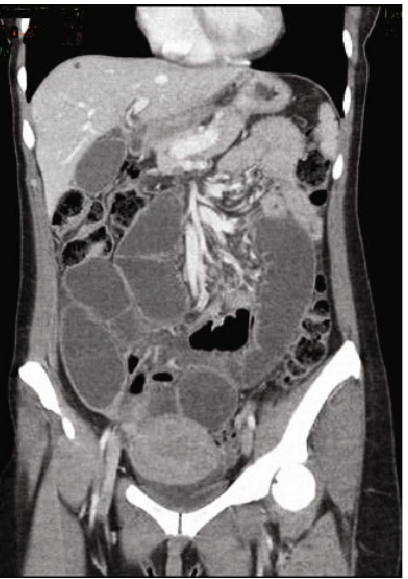
Figure 1: Abdominal computed tomographic scan showing dilated small bowel loops.